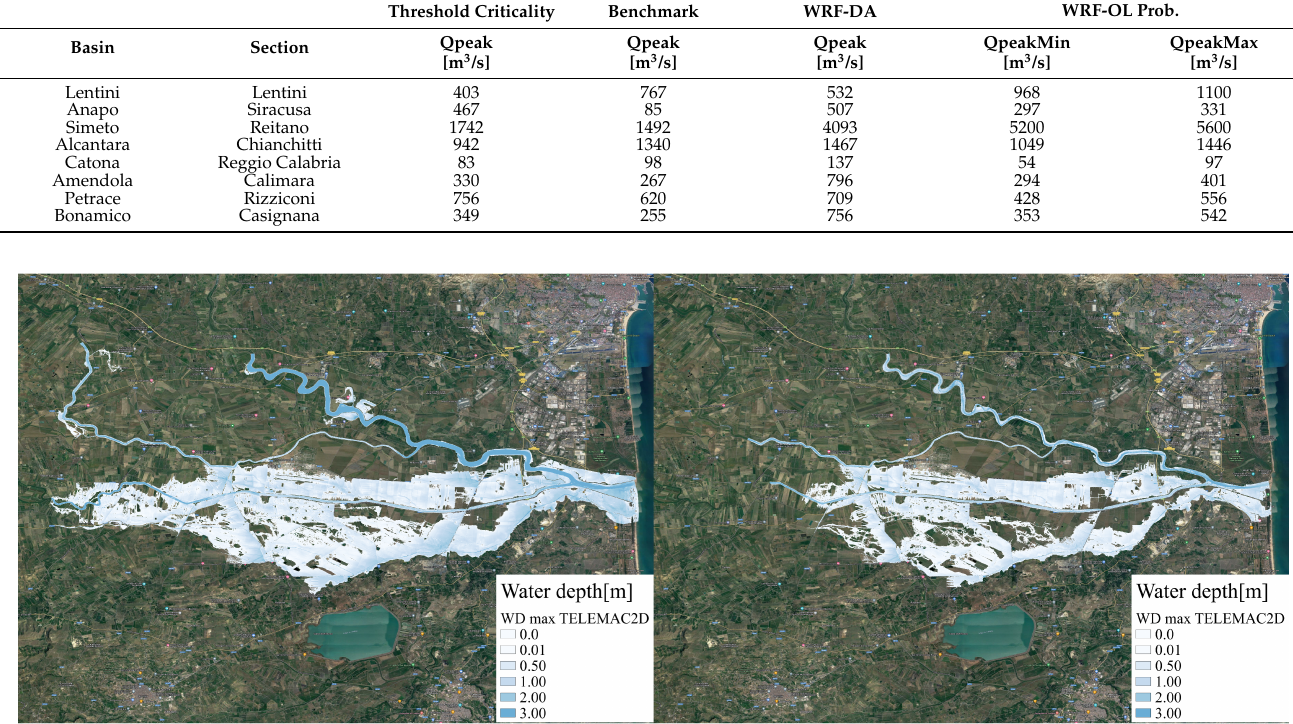
Figure 16. Comparison between forecast flooded area ( left panel ) using WRF-DA forecast run of 24 October at 00UTC and flooded area using ground data as input for Flood-PROOFS ( right panel